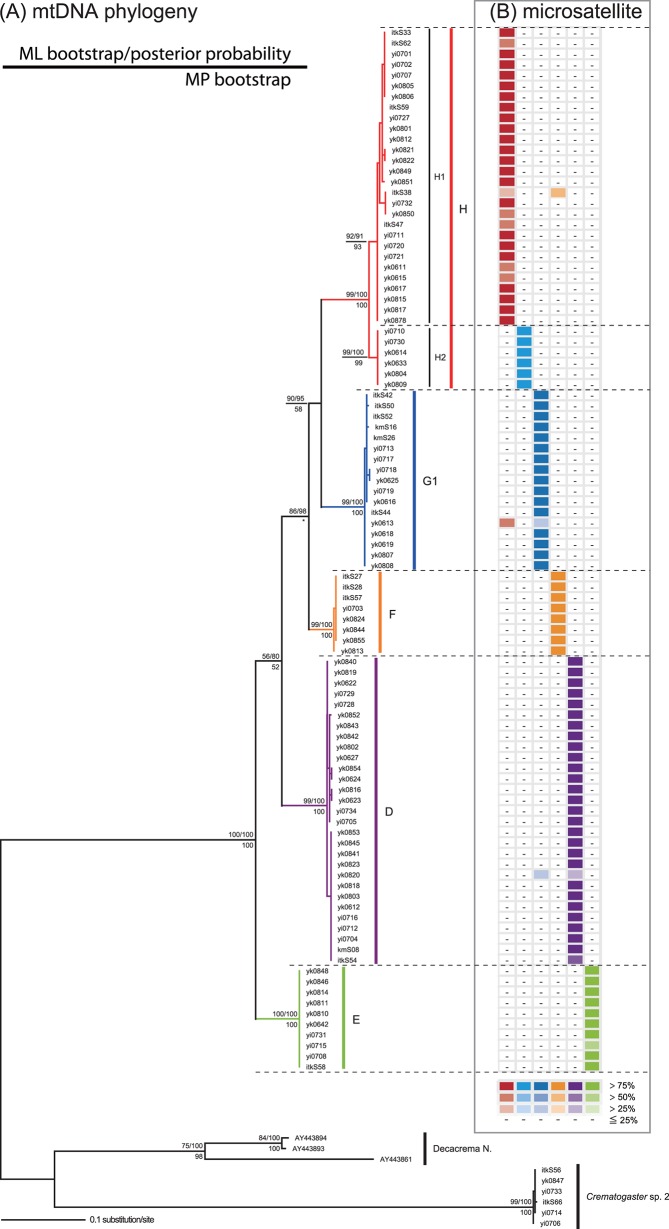
Comparison between the mtDNA phylogeny (A) and nrDNA SSR genotyping (B).The maximum likelihood (ML) phylogeny of 98 samples of Decacrema ants inhabiting Macaranga in Lambir Hills National Park was inferred from a 569-bp DNA sequence of the mitochondrial gene cytochrome oxidase I. The numbers above the branches are the ML bootstrap support/Bayesian posterior probability ratio, and those below the branches indicate the maximum parsimony (MP) bootstrap support. An asterisk (*) replaces one node bootstrap support value because the node was not recovered in the MP bootstrap analysis. The same individuals that were used for the mtDNA phylogeny were genotyped for the five microsatellite loci. The admixture level of each genotype in individual samples is indicated by the color intensity as shown at the bottom of (B).